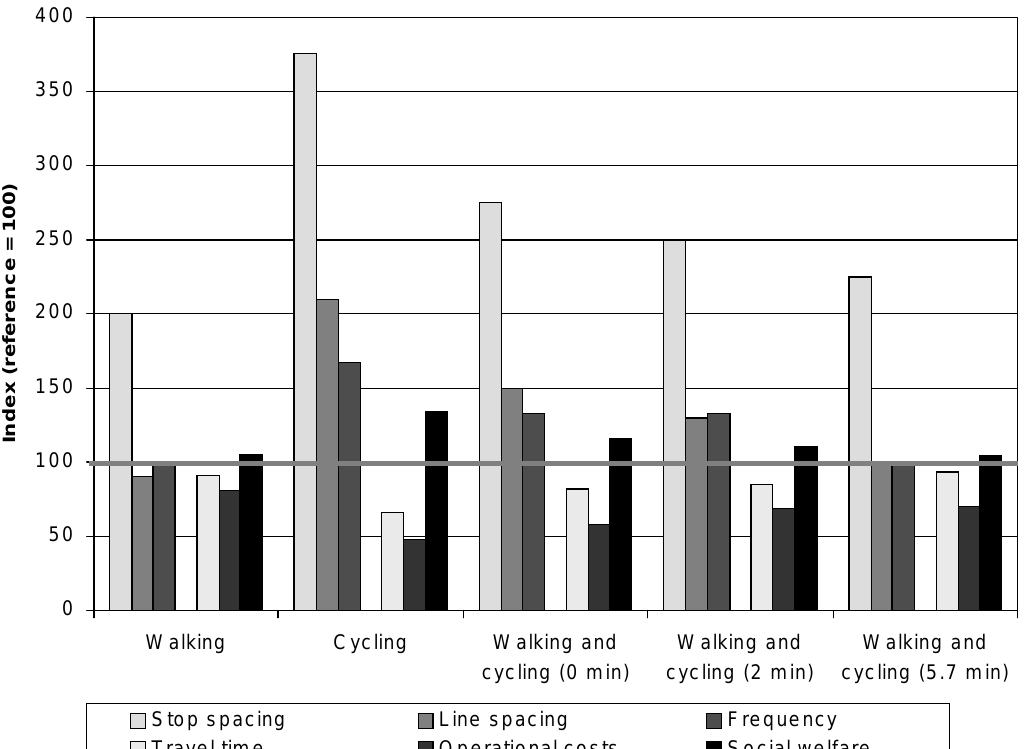
Figure 5. Main network and performance characteristics for different access modes as an index to the reference